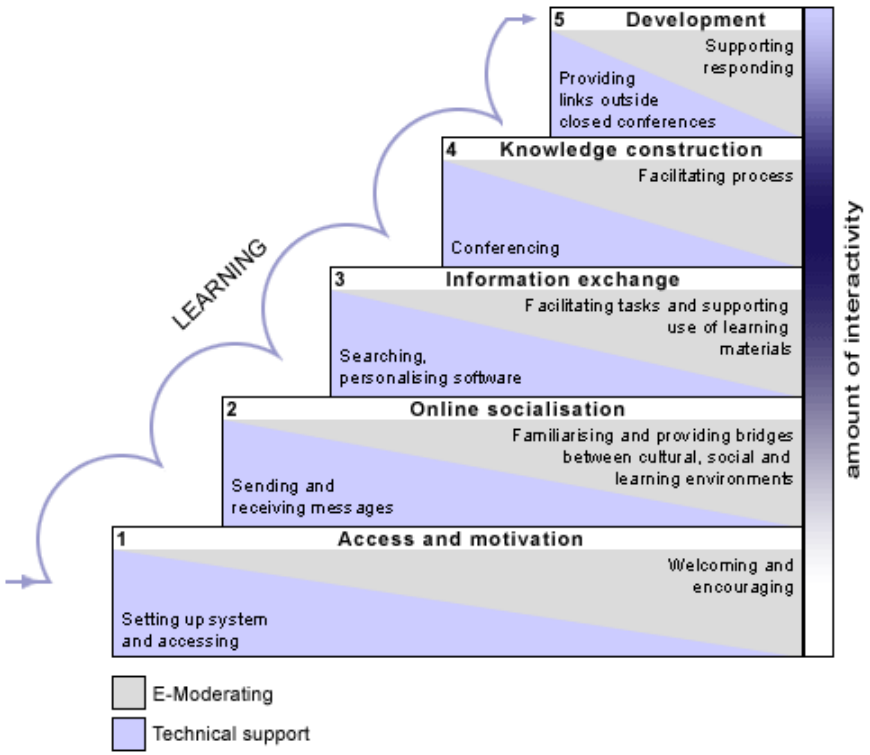
Figure 1 . Model of teaching and learning online. From E-Moderating: The Key to Teaching and Learning Online (2nd ed., p. 29) by Gilly Salmon (2004), New York and London: Routledge. Reprinted with